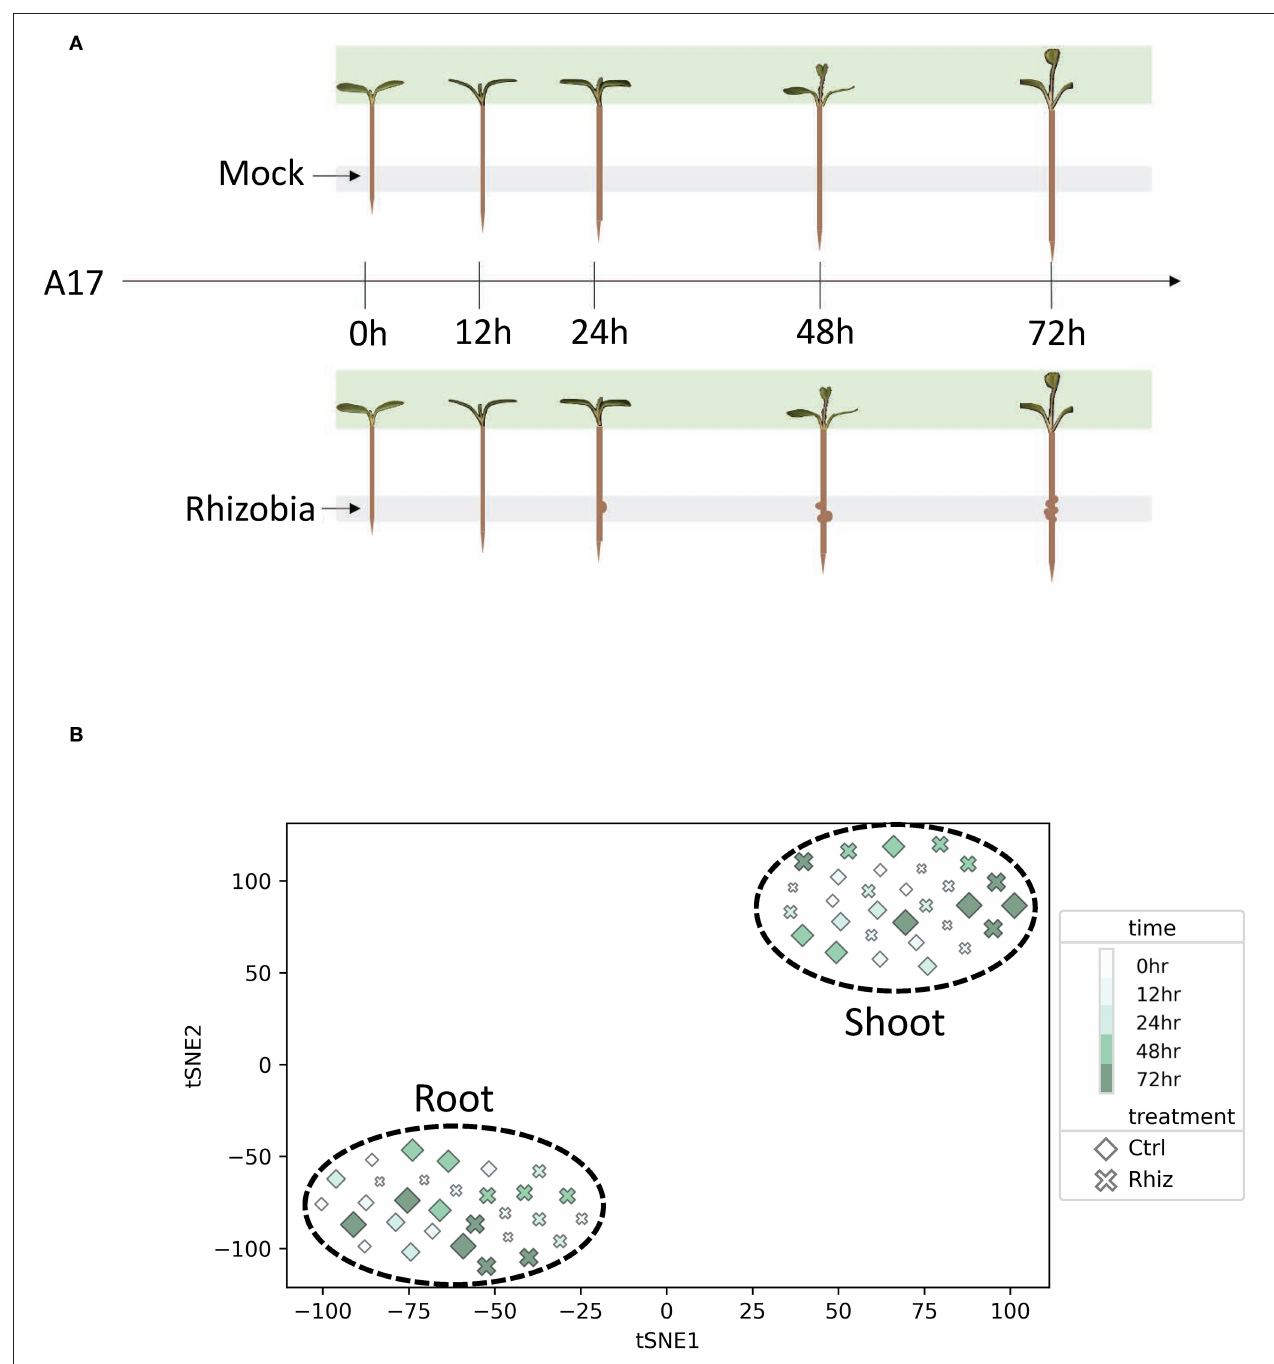
FIGURE 1 | Root and shoot displayed transcriptional differences in control and rhizobia samples. (A) Experimental design for the Medicago truncatula transcriptomics experiment. Gray and green shades represent harvest tissue locations for RNA-seq library construction. (B) T-distributed stochastic neighbor embedding (tSNE) reveals the transcriptional difference between rhizobia and control samples in root vs. shoot.